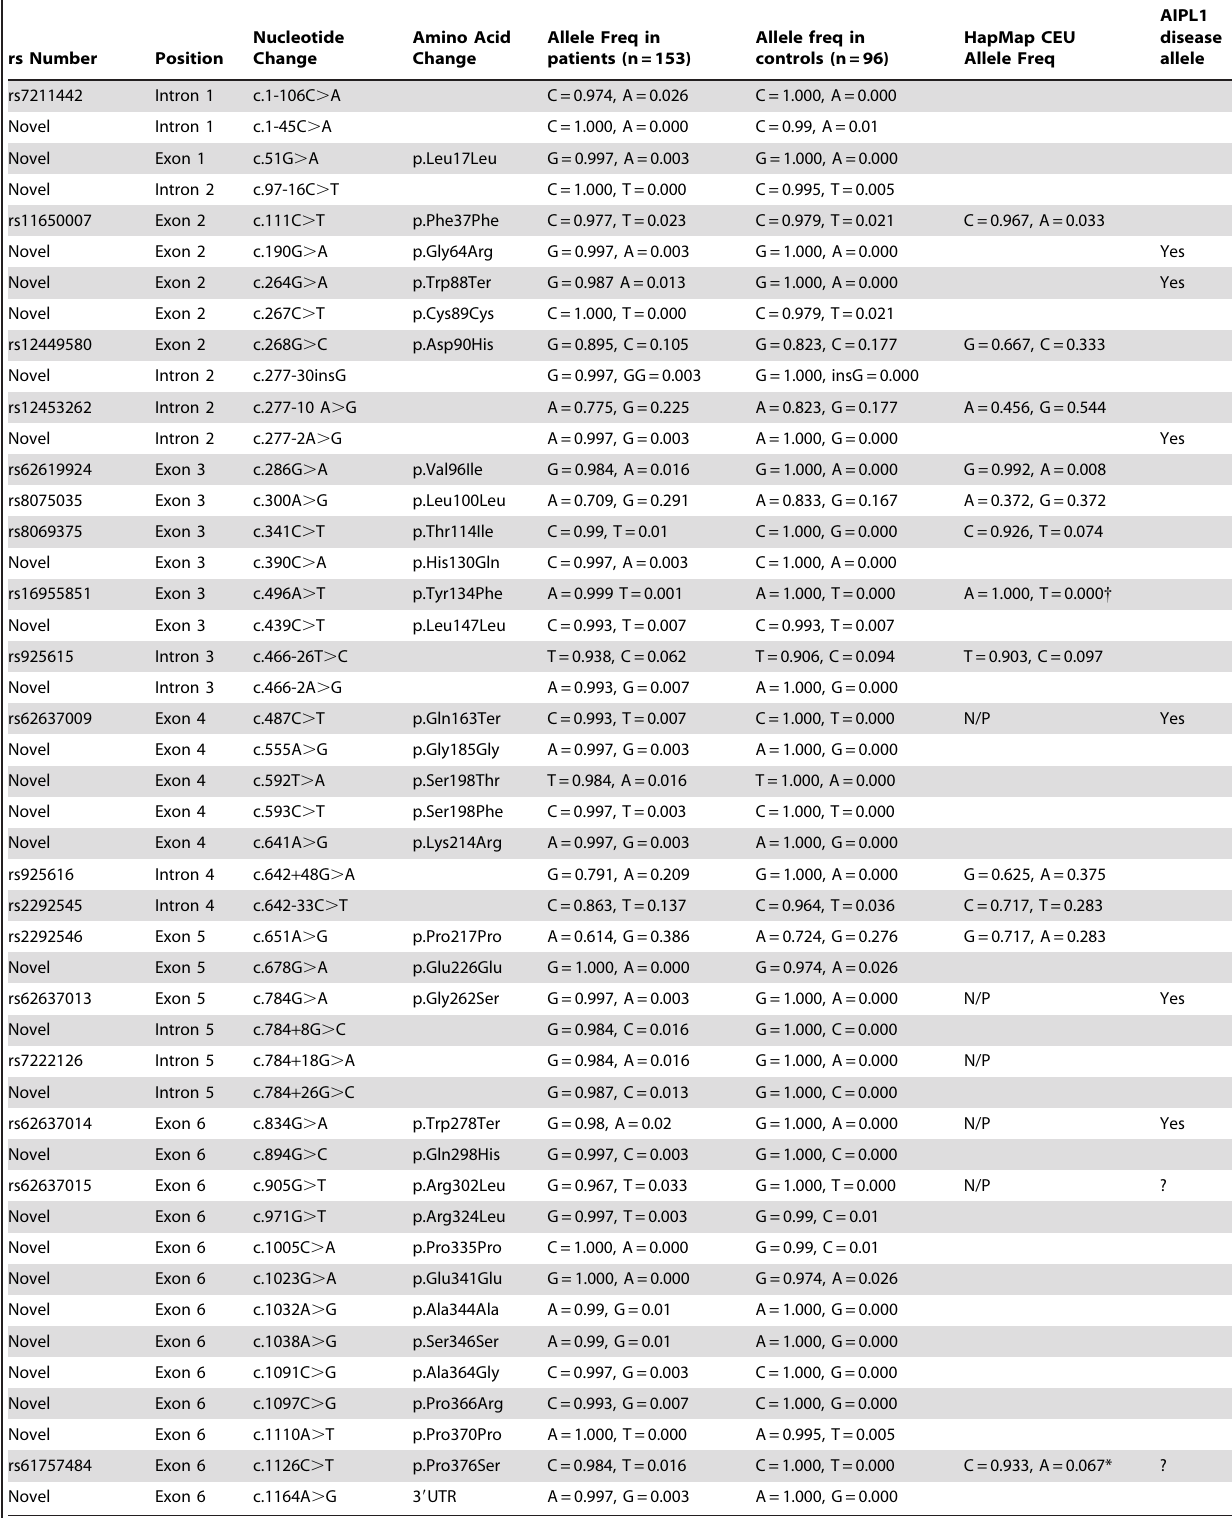
Table 1. Variants identified in AIPL1 in patients and